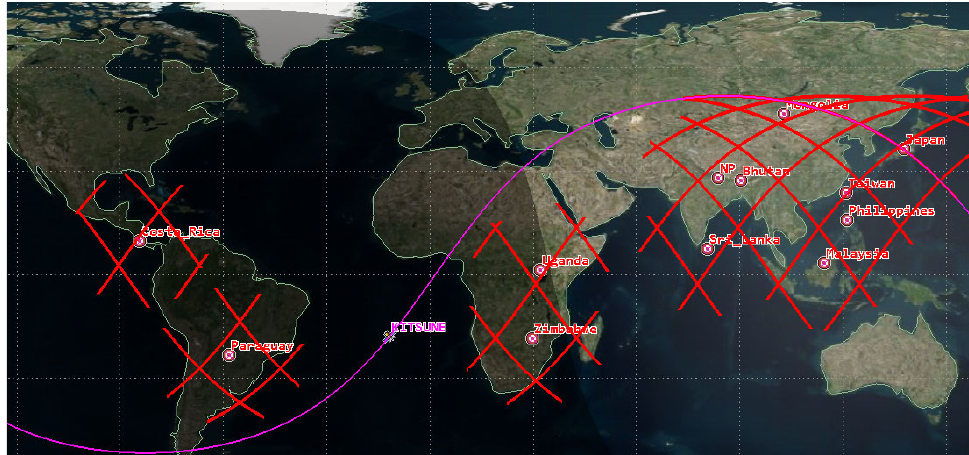
Figure 14. Satellite passes for KITSUNE in GST countries for 24 h.